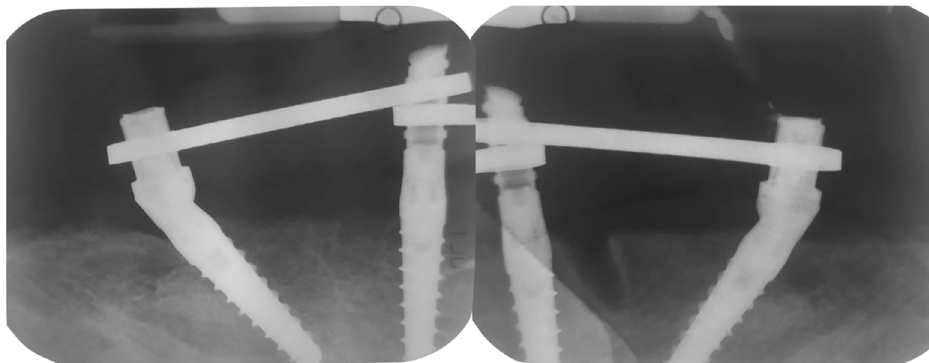
Figure 8. Provisional full-arch prosthesis.